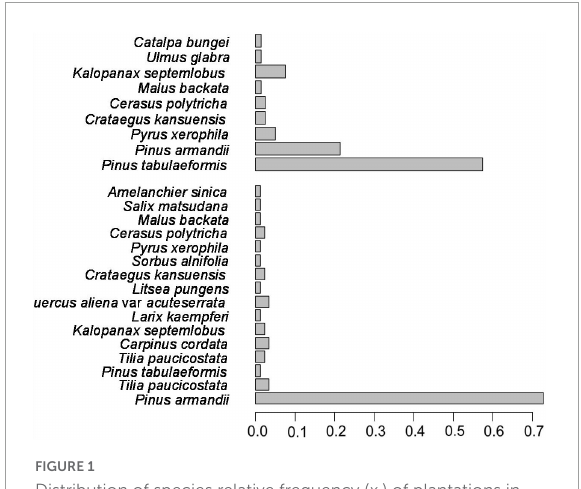
FIGURE1 Distribution of species relative frequency ( x i ) of plantations in Xiaolongshan mountain.